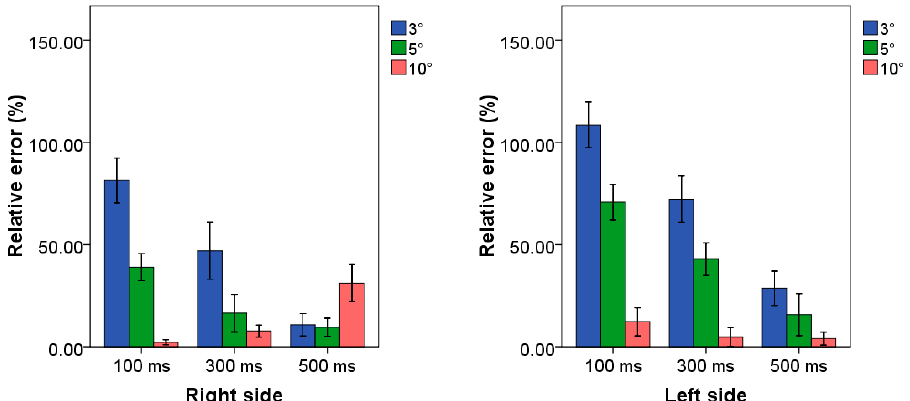
Figure 5. Mean value and standard deviation of relative error related to the case study at high frequency for both side of all combinations of TB procedure. Blue, green and red bars represent the combination in which the threshold amplitude is set to 3°, 5° and 10°, respectively. Clusters on x -axis represent the possible time threshold value. Each bar corresponds to a specific combination among the nine tested algorithms.